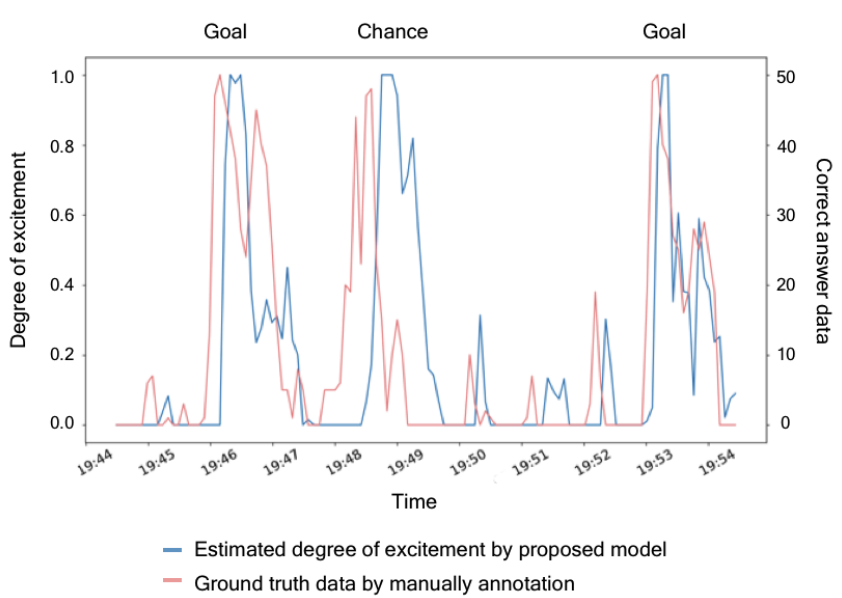
Figure 3. Estimated degree of excitement (blue lines) and the ground truth (pink